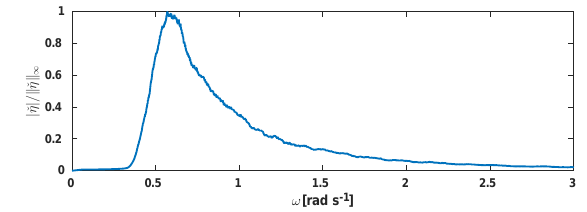
Figure 11. The same as Fig. 7; now for the case